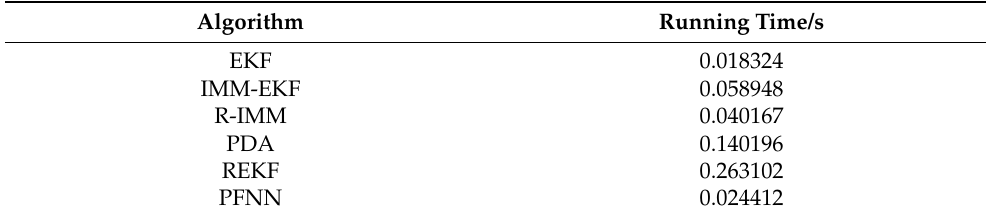
Table 4. Total computational